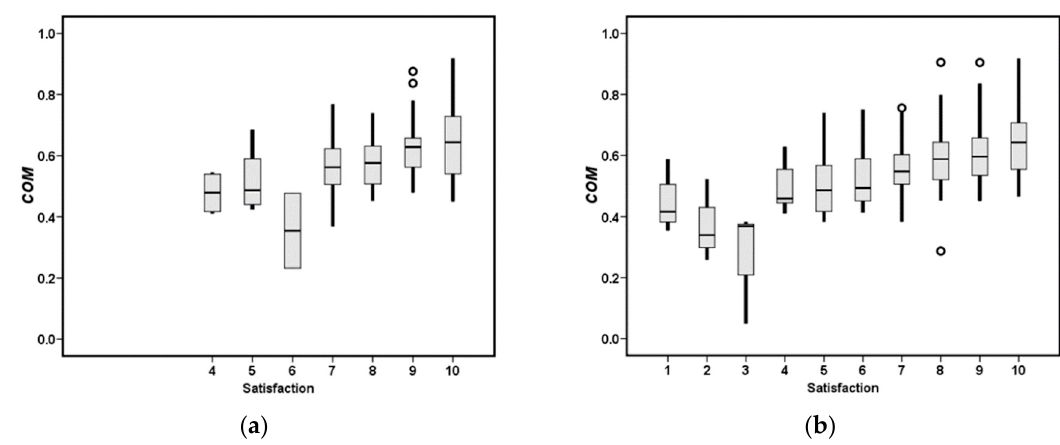
Figure 4. Interdependency between overall satisfaction with the service and the COM variable (Capability-Opportunity-Motivation) of: ( a ) professional soldiers, ( b ) conscripts.